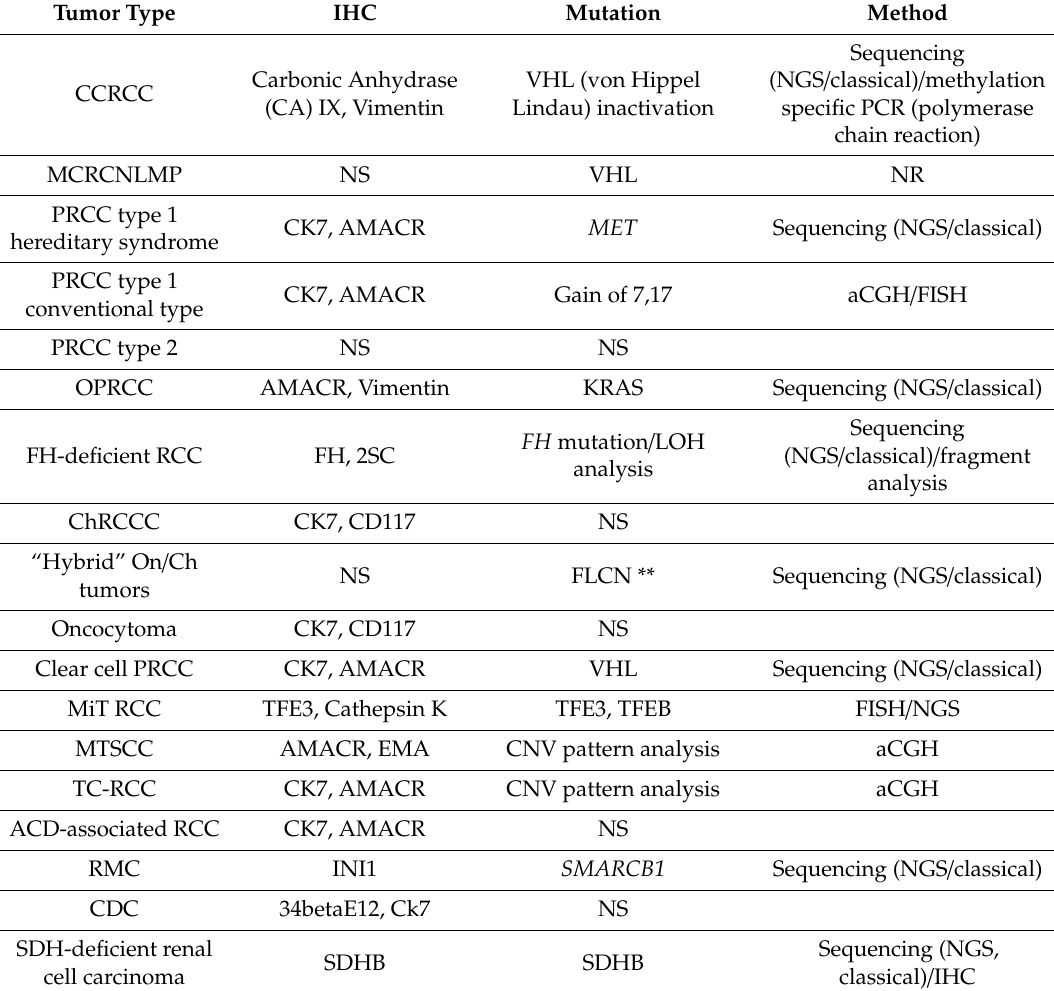
Table 1. Genetic tests and routinely used immunohistochemical examinations in renal cell tumors Tumor Type IHC Mutation Method Carbonic Anhydrase CCRCC (CA) IX, Vimentin Lindau) inactivation